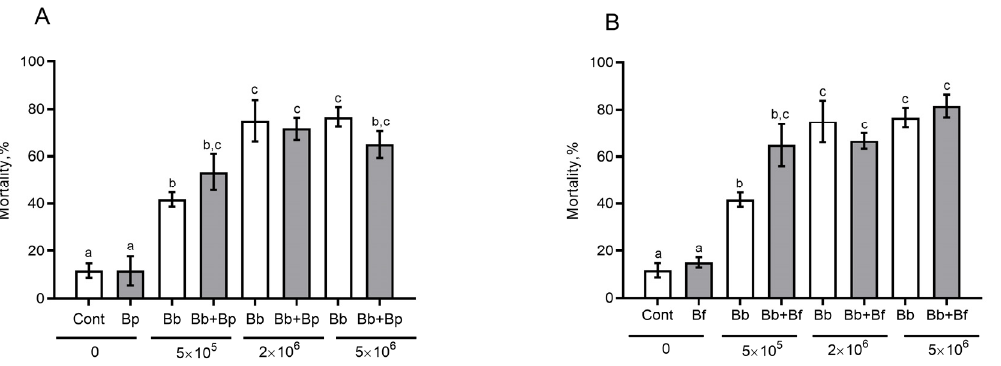
Figure 5. CPB mortality during 30 days after burial into the sterile soil inoculated with B. bassiana (Bb) conidia at three concentrations and with soil bacteria at the concentration 10 7 cells/(g of soil): ( A ) Bacillus pumilus (Bp); ( B ) B. frigoritolerans (Bf). Different letters indicate significant differences between treatment groups (Tukey’s test p <